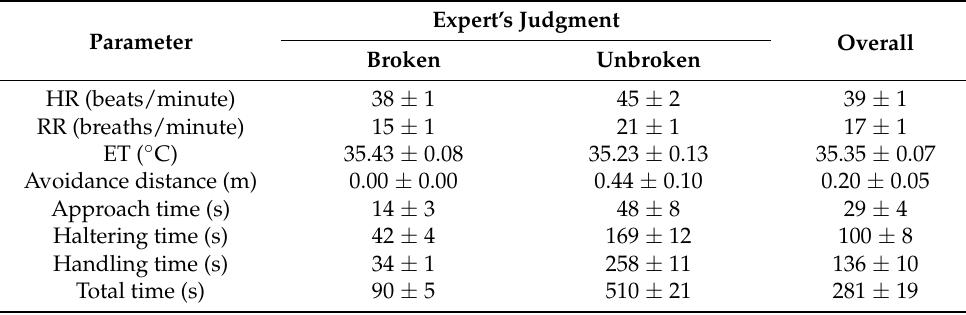
Table 6. Descriptive statistics for physiological and behavioural parameters.